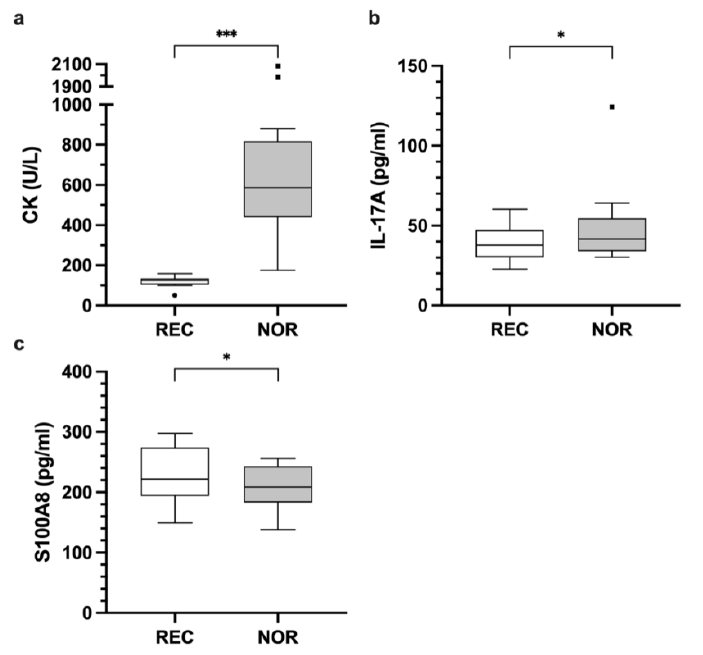
Figure 2. Enzyme activity of CK ( a ), concentration of IL-17A ( b ), and S100A8 ( c ) in badminton players at REC and NOR time points. (*) indicates P < 0.05 and (***) indicates P < 0.001. Raw data are shown.